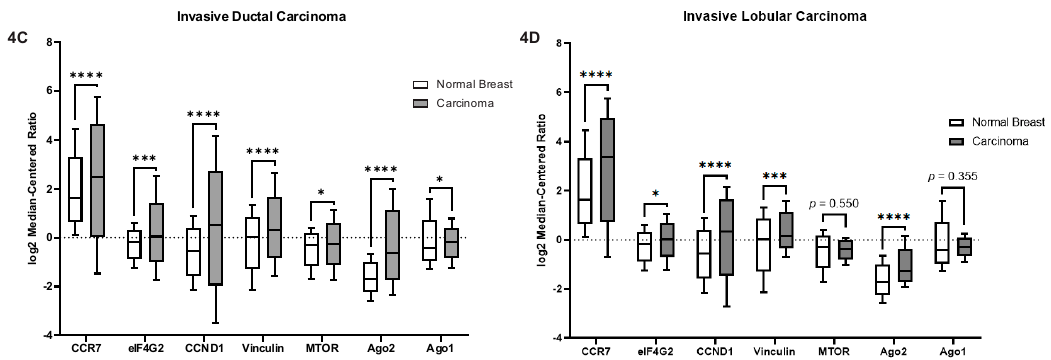
Figure 4. Let-7a and miR-100 targets are upregulated in Breast Carcinomas. Gene expression data from breast carcinoma patients was analyzed using Oncomine™ (https://www.oncomine.org/). Both the Curtis Breast and TCGA Breast datasets were analyzed and results presented as box and whisker plots of the log2 median-centered ratio (Fold change). ( A ) Curtis Breast Invasive Ductal Carcinoma ( n = 1556) vs. normal breast ( n = 144). ( B ) Curtis Breast Invasive Lobular Carcinoma ( n = 148) vs. normal breast ( n = 144). ( C ) TCGA Breast Invasive Ductal Carcinoma ( n = 389) vs. normal breast ( n = 61). ( D ) TCGA Breast Invasive Lobular Carcinoma ( n = 36) vs. normal breast ( n = 61). Box edges represent the 25th and 75th percentiles, and whiskers represent the minimum and maximum. ****, ***, **, and * indicate p < 0.0001, p < 0.001, p < 0.01, and p < 0.05 respectively, evaluated by Student t -test.